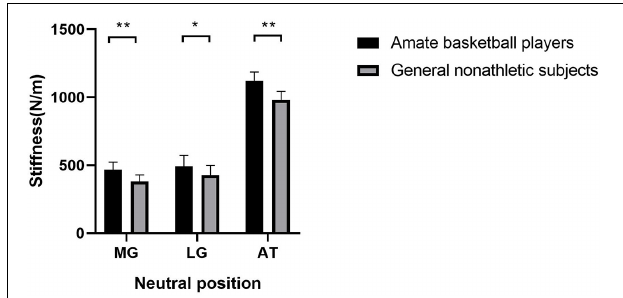
FIGURE 1 | The mean stiffness of the lateral gastrocnemius (LG), medial gastrocnemius (MG), and Achilles tendon (AT) between amateur basketball players and general non-athletic subjects at ankle neutral position. Amateur basketball players (black) and general non-athletic subjects (gray). ** P < 0.001, * P < 0.05.